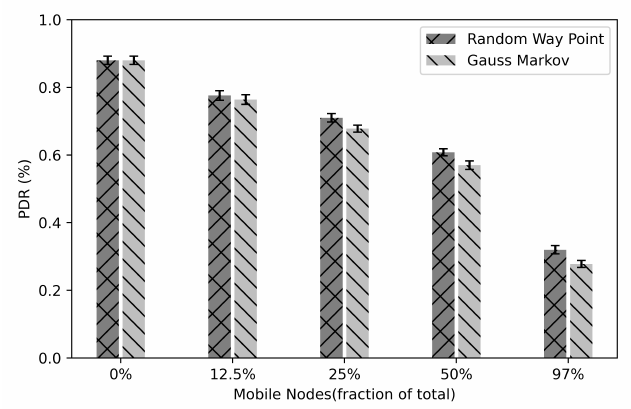
Figure 15. Lookups PDR as a function of the fraction of mobile nodes utilizing Random Way Point and Gauss Markov mobility